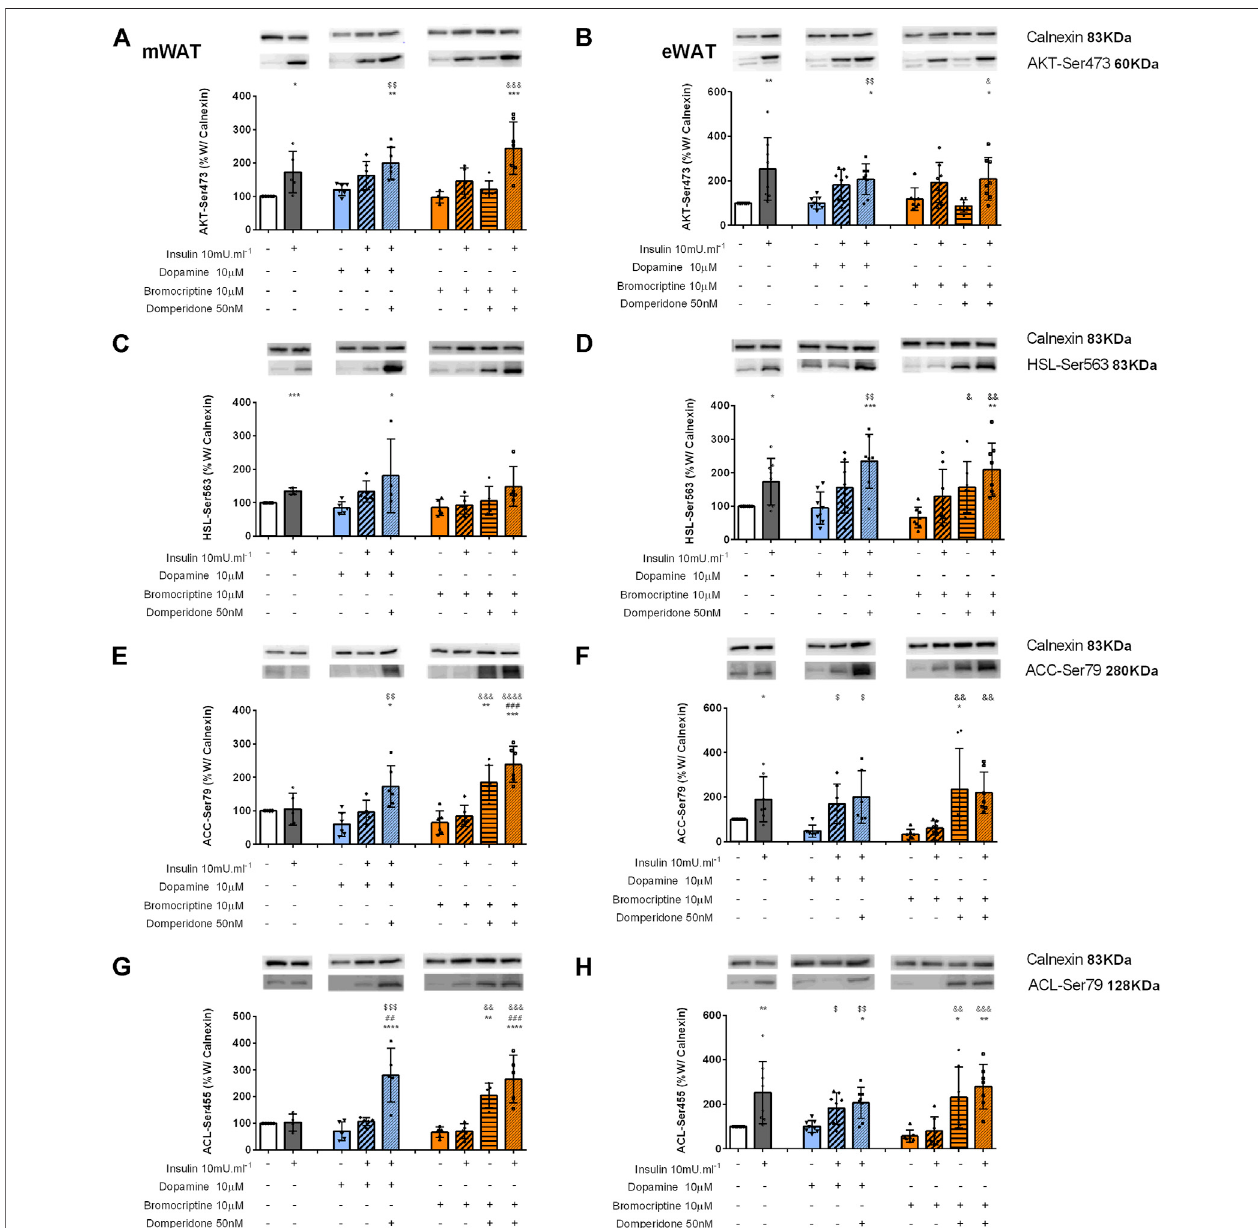
FIGURE 6 | Involvement of dopamine and bromocriptine on Akt (A,B) , HSL (C,D) , ACC (E,F) , and ACL (G,H) phosphorylation in mWAT and eWAT, respectively. Figuresshowtheeffectofdopamine(10 μ M,bluebars)andtheeffectofbromocriptine(10 μ M,orangebars)onmWATandeWAT.Akt (A,B) ,HSL (C,D) ,ACC (E,F) ,and ACL (G,H) phosphorylation, and its blockade by domperidone (50 nM). The insulin dose used was 10m U ml − 1 . The top of fi gures show representative Western blots for the effect of insulin, dopamine, and bromocriptine in the presence or absence of domperidone, a D2R antagonist, on Akt-Ser743 (A,B) , HSL-Ser563 (C,D) , ACC-Ser79 (E,F) , and ACL-Ser455 (G,H) phosphorylation, where the bands on the top represent calnexin (83 kDa band), the loading control, and the bands below show the proteins of interest – Akt-Ser743, HSL-Ser563, ACC-Ser79, and ACL-Ser455. Bars represent means ± SD. On the bottom of the bars are shown the different conditions used for each group tested with + meaning presence of that stimuli and – absence of it. One-way ANOVA with Dunnet ’ s post hoc comparison test * vs . control; # vs . insulin; $ vs . dopamine; & vs . bromocriptine. Levels of signi fi cance: * p < 0.05; ** p < 0.01; *** p < 0.001; **** p < 0.0001. mWAT, mesenteric white adipose tissue; eWAT, epididymal white adipose tissue; and D2R, dopamine receptor type 2.